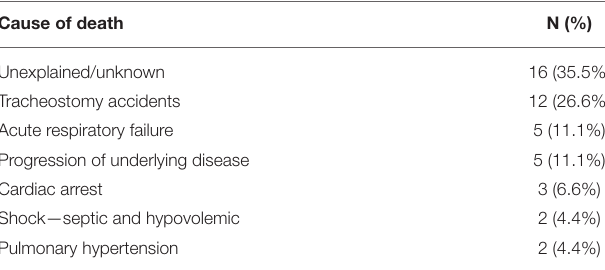
TABLE 4 | Analysis of risk factors associated with mortality. TABLE 5 | Cause of death ( N =